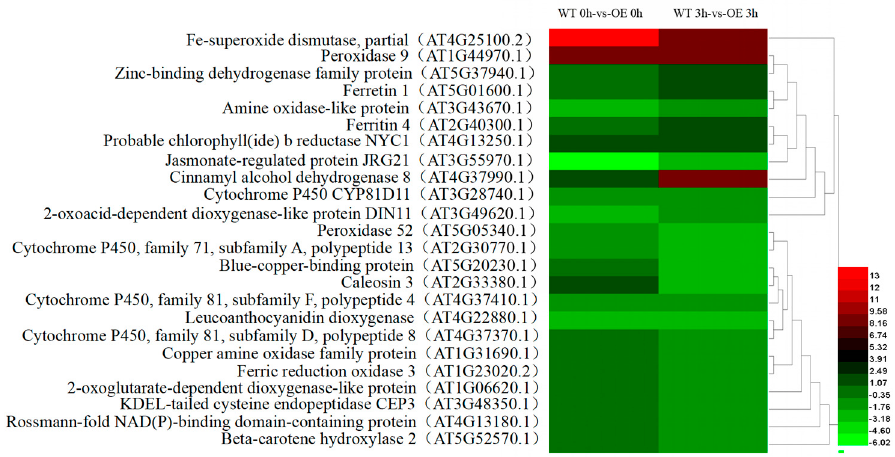
Figure 8. Expression analysis of DEGs involved in redox reaction processes during salt stress exposure.